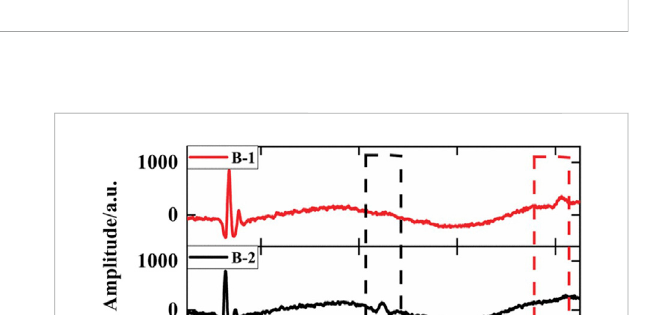
FIGURE 8 Schematic of re fl ective THz-TDS system (Li et al.,2021).